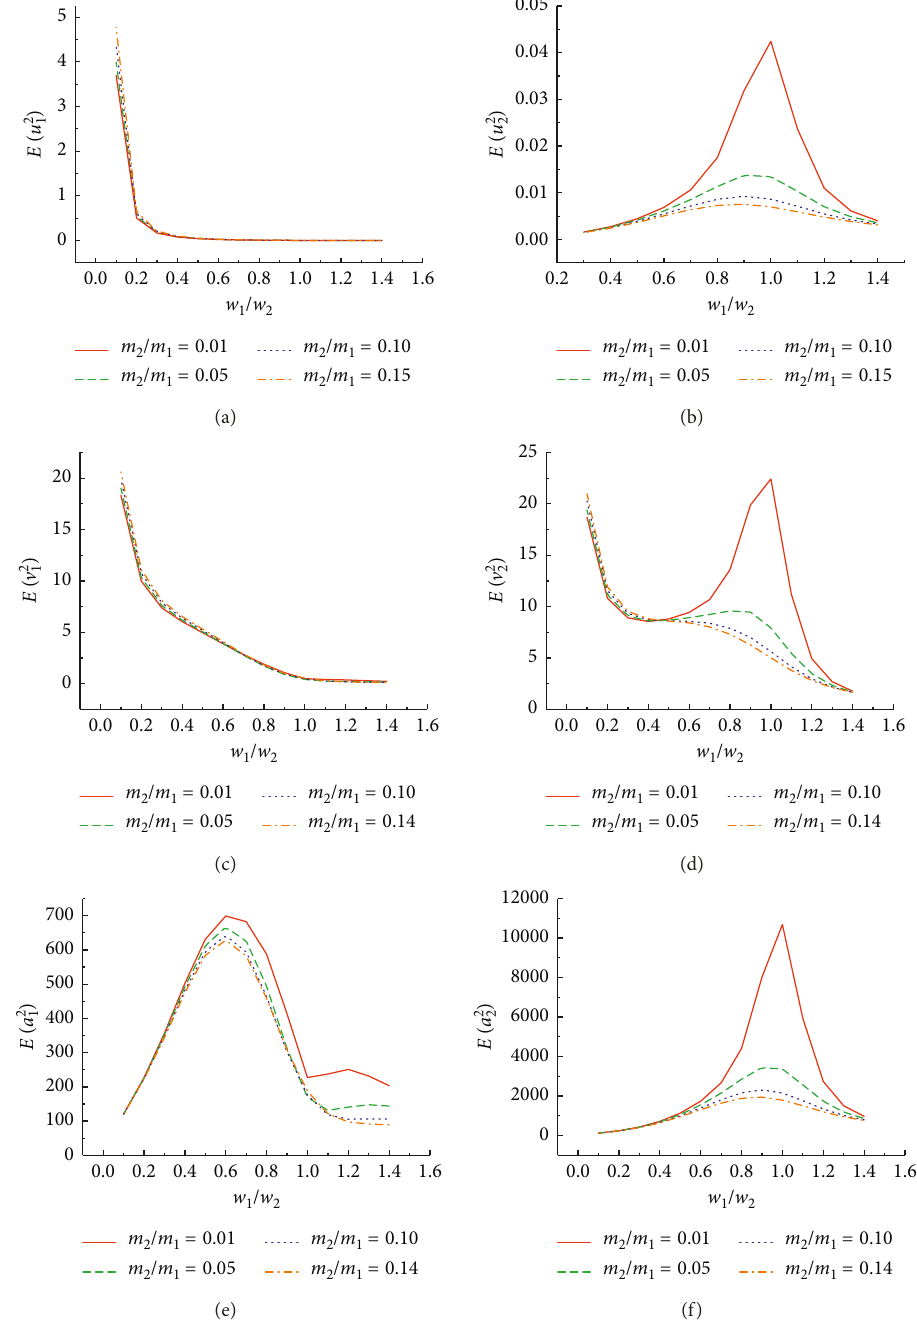
Figure 4: Parameter variances of primary-secondary coupled system under seismic motion. (a) Variance of primary structure. (b) Displacement variance of secondary structure. (c) Velocity variance of primary structure. (d) Velocity variance of secondary structure. (e) Acceleration variance of primary structure. (f) Acceleration variance of secondary